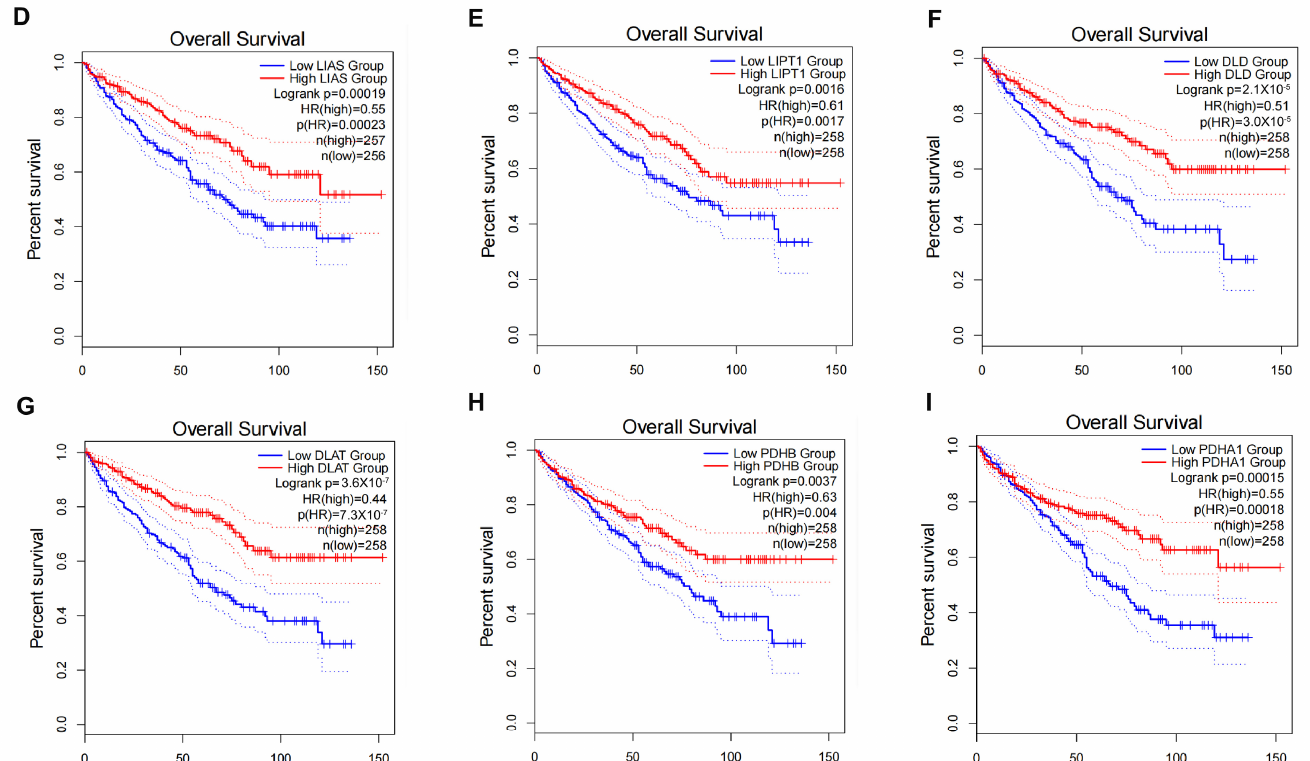
Figure 1. Clinical significance of cuproptosis regulators in ccRCC. ( A ) Expression levels of cuproptosis regulators between ccRCC and normal kidney tissues. ( B ) Methylation on promoter regions of cuproptosis regulators between ccRCC and normal kidney tissues. ( C – I ) High expression of FDX1 ( C ), DLAT ( D ), DLD ( E ), PDHB ( F ), LIAS ( G ), LIPT1 ( H ), and PDHA1 ( I ) predicted longer survival in ccRCC according to Kaplan–Meier survival analyses. * p < 0.05, *** p < 0.001, **** p < 0.0001; n.s. = no